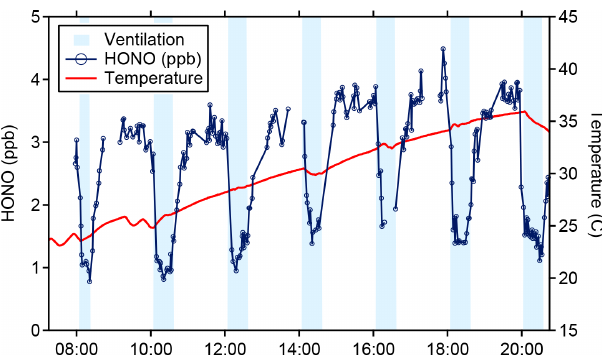
Figure 8. HONO (blue) and temperature (red) data from the 4 June ventilation experiment during the HOMEChem study. Shaded areas represent ventilation periods (open doors and